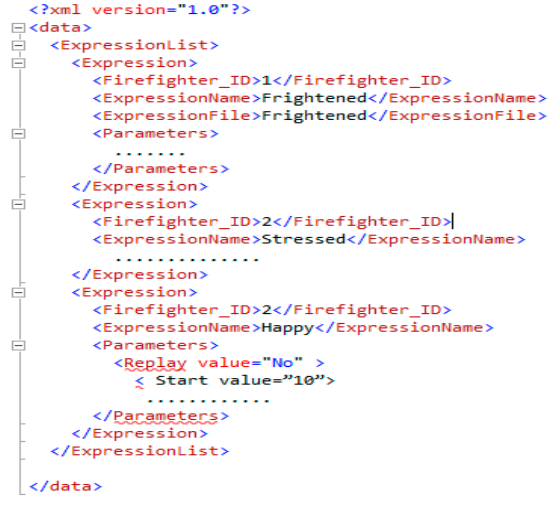
Figure 14. XML file for face control.